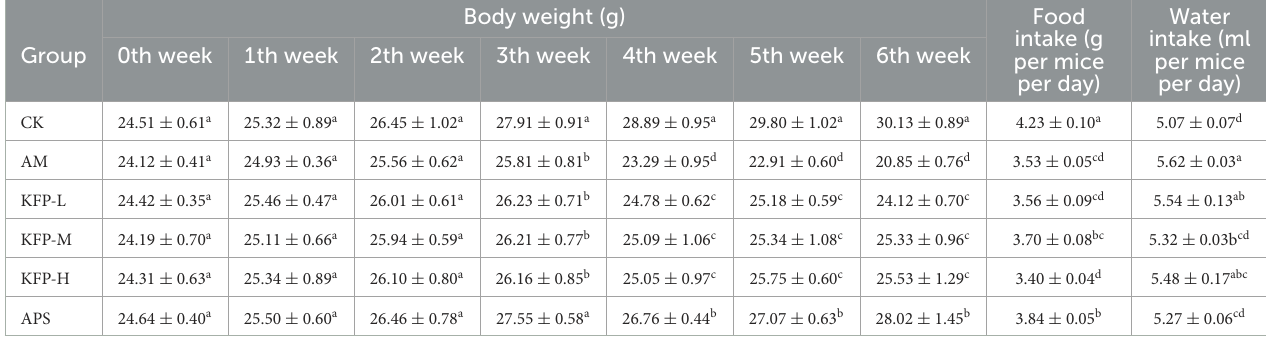
TABLE 1 The effects of KFP on body weight, food and water intake in AA-induced mice (mean ± SD, n = 10).